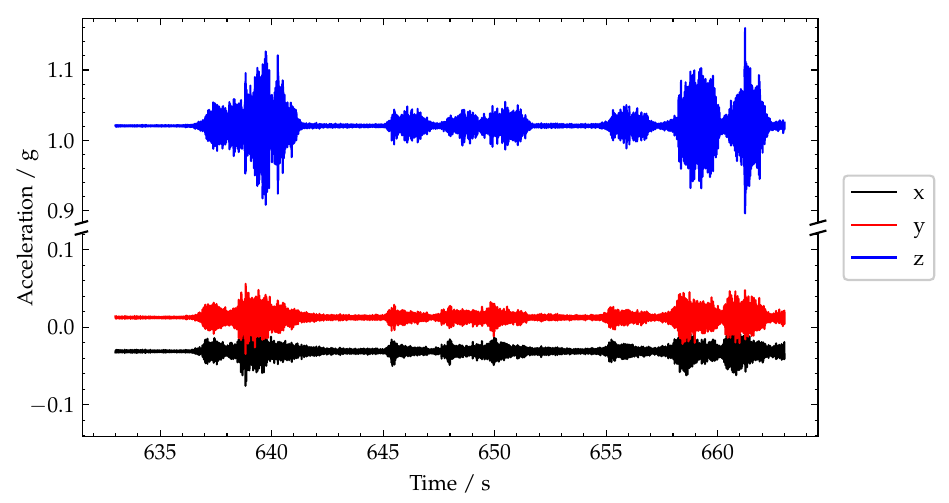
Figure 15. Plot of recorded acceleration